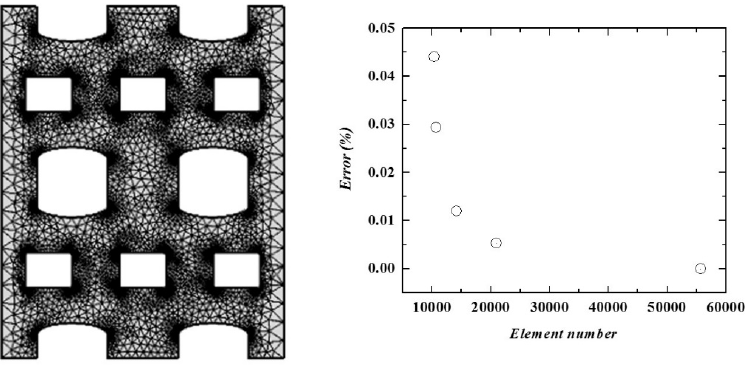
Figure 3. Mesh sensitivity test.